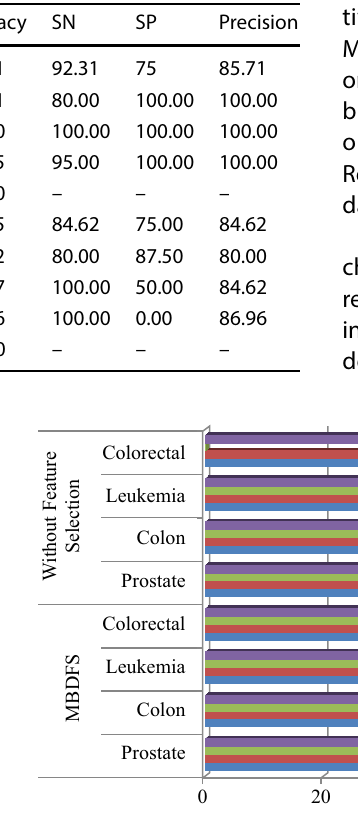
Table 4 MBDFS Vs Feature-free Selection